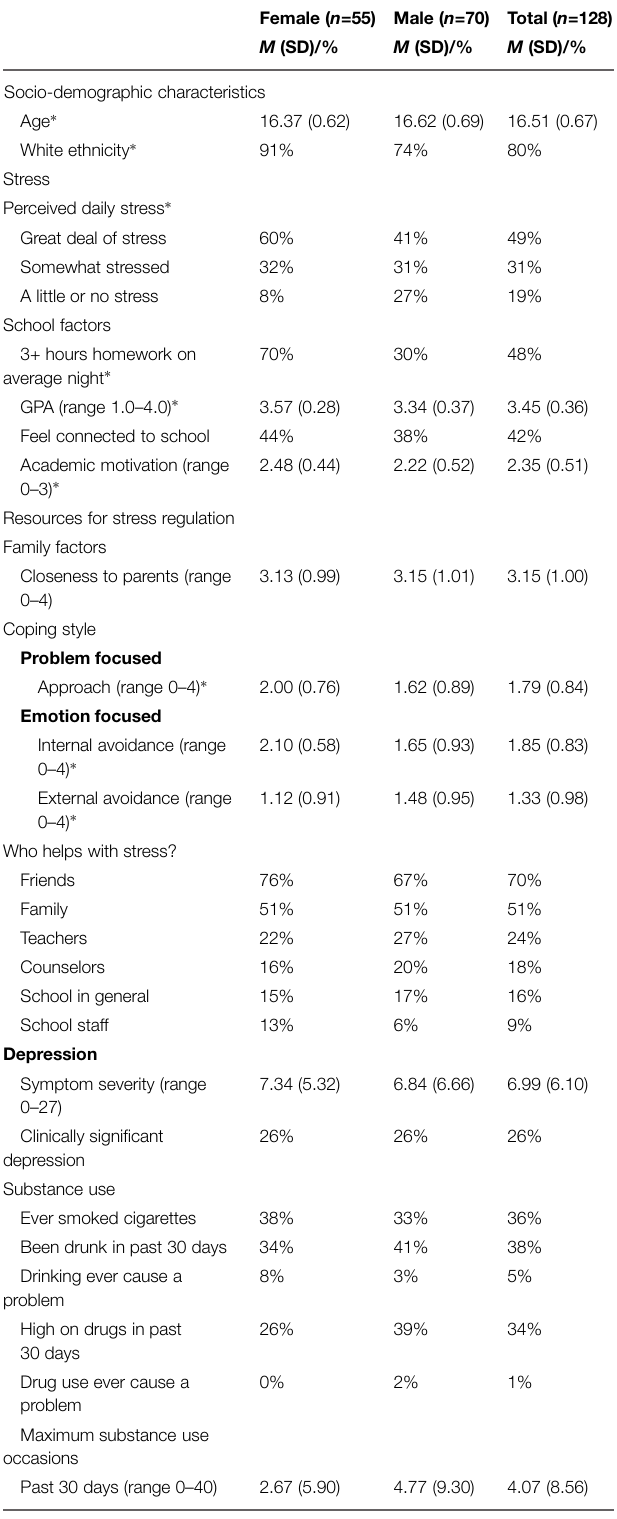
TABLE 1 | Student socio-demographic characteristics, stress, resources for stress regulation, depression, and substance use.